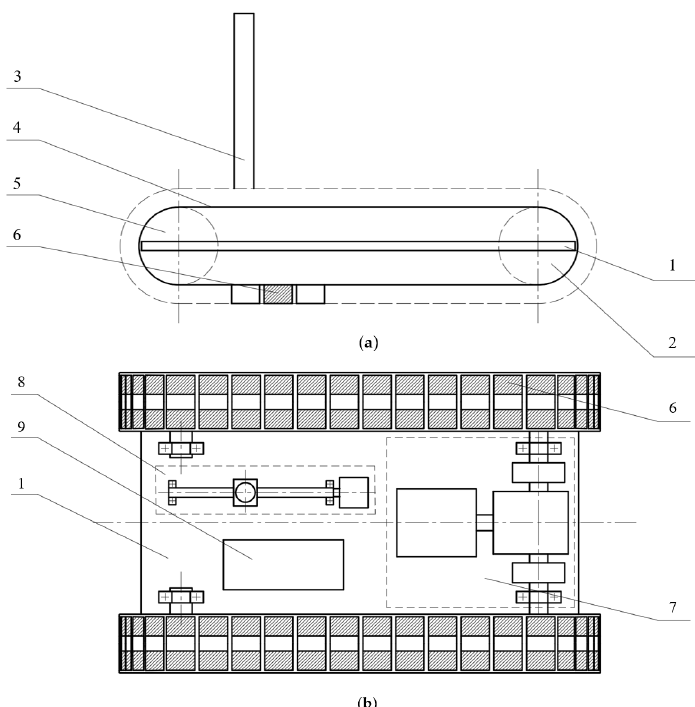
Figure 2. Mechanical structure of the tracked wall-climbing robot (TWCR): ( a ) Right view ( b ) top view (1—baseboard, 2—driving wheel, 3—scale, 4—tracks, 5—driven wheel, 6—permanent magnetic units, 7—driving, transmission, and steering mechanism, 8—scale moving, and collapsing mechanism, 9—microcontroller).